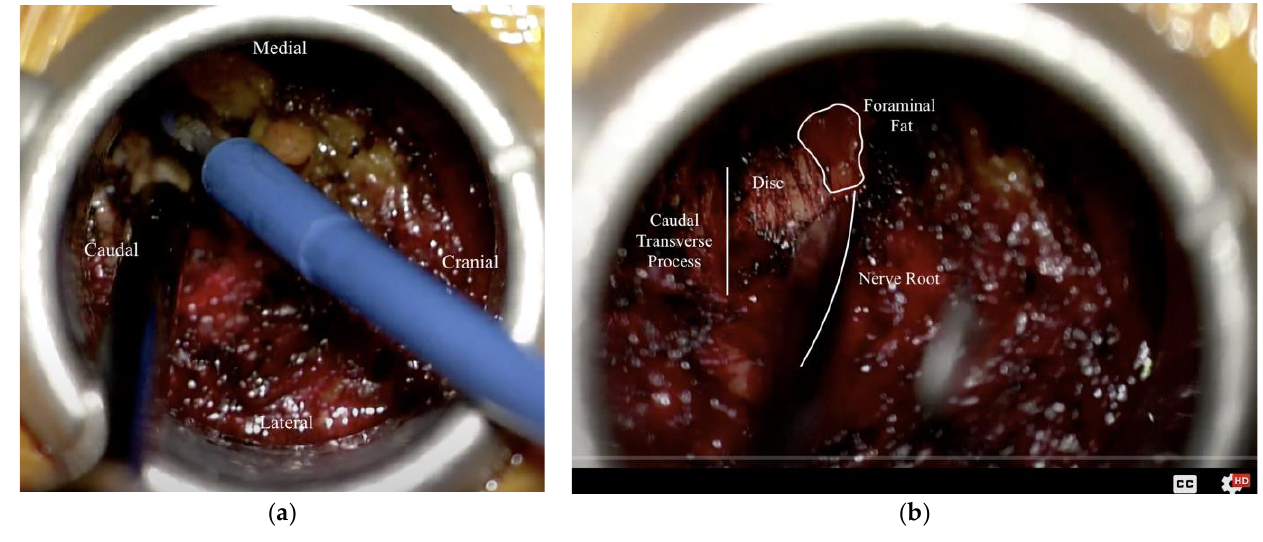
Figure 3. Intra-operative photo from a right-sided (ipsilateral) extra-foraminal approach to the L4–5 FLDH. ( a ) Exposure of the caudal transverse process and facet junction using the Bovie electro- cautery; ( b ) Following the partial removal of the overlying intertransverse membrane attached to the caudal transverse process, immediately exposing the disc space, allowing for further exploration of the foramen (fat contained within the foramen is highlighted) as well as the exiting nerve root without need for complete stripping of overlying soft tissue.